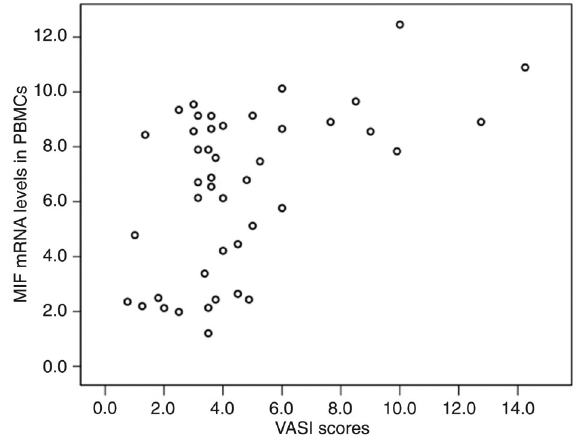
Figure 3. Serum migration inhibitory factor (MIF) concentrations of vitiligo vulgaris patients and normal controls. Vitiligo-A = Progressive vitiligo; Vitiligo-B = stable vitiligo. *P , 0.01 compared to normal controls (NC); # P , 0.05 compared to Vitiligo-A (Mann-Whitney U-test).